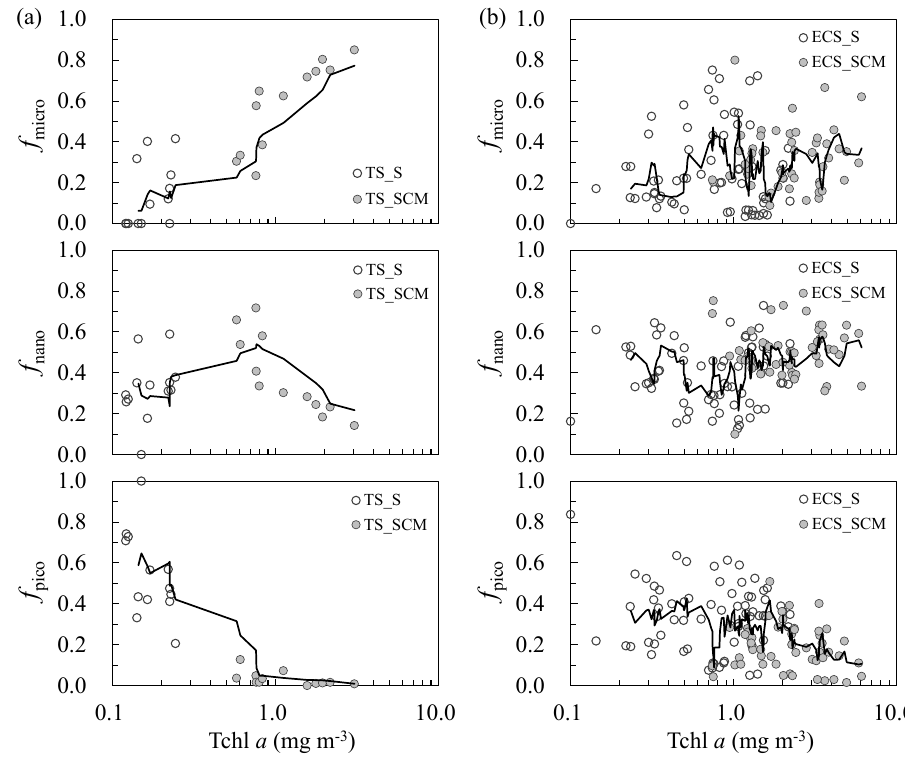
Fig. 6. Variations in Tchl a size-fractions of micro-, nano- and pico-phytoplankton as a function of Tchl a in the Tsushima Strait (TS) (a) and East China Sea (ECS) (b) . TS_S, TS_SCM, ECS_S and ECS_SCM represent the Tsushima Strait surface, Tsushima Strait SCM, East China Sea surface, and East China Sea SCM, respectively. Lines represent the five-point running